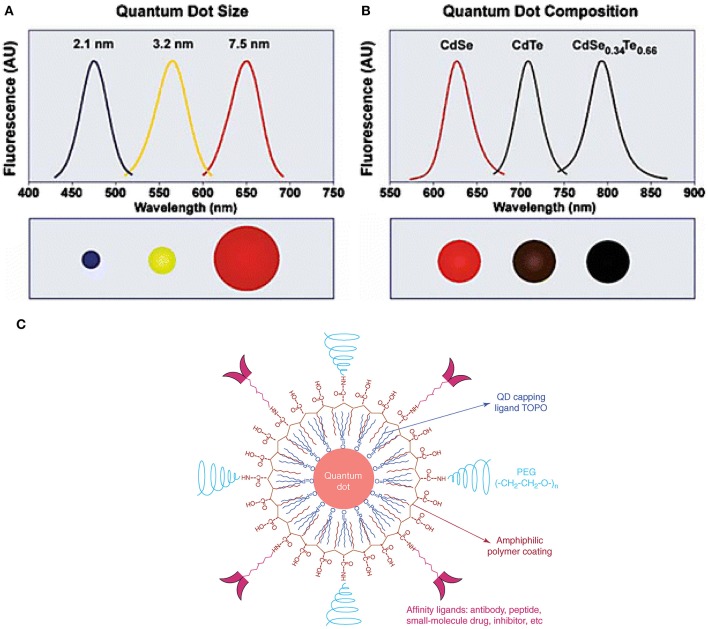
QDs structure and novel optical properties: (A) Size and composition tuning of optical emission for binary CdSe and ternary CdSeTe quantum dots. A CdSe QD with various sizes (given as diameter) may be tuned to emit throughout the visible region by changing the nanoparticle size while keeping the composition constant. (B) The size of QD may also be held constant, and the composition may be used to alter the emission wavelength. In the above example, 5-nm-diameter quantum dots of the ternary alloy CdSexTe1−x may be tuned to emit at longer wavelengths than either of the binary compounds CdSe and CdTe because of a non-linear relationship between the alloy bandgap energy and composition (the spectrum maximum near 790 nm corresponds to CdSe0.34Te0.66). (C) The structure of a multifunctional QD probe. Schematic illustration showing the capping ligand TOPO, an encapsulating copolymer layer, tumor-targeting ligands (such as peptides, antibodies or small-molecule inhibitors), and polyethylene glycol (PEG) (Smith et al., 2004; Gao et al., 2005). Reproduced with permission. Copyrights 2004 John Wiley and Sons and 2005 Elsevier.